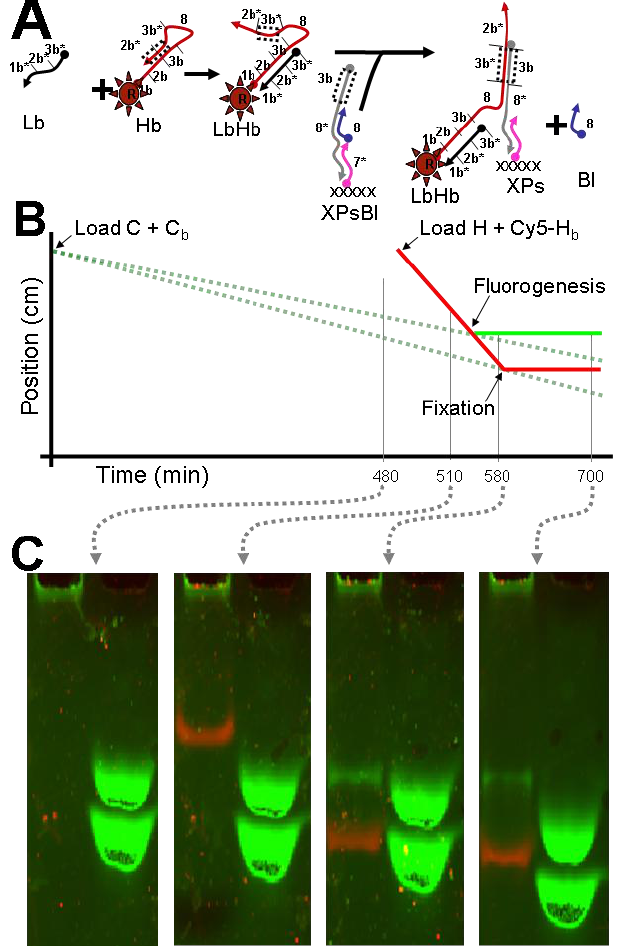
Figure 4. DNA reactions cause fluorescence and mobility changes in situ . ( A ) Schematic illustration of the fixation reaction that leads to a decrease in the mobility of Cy5-labeled Hb; ( B ) Graph showing the motion of the DNA species over time in the gel. The L species are injected and electrophorese down the gel. H species are then injected; they move much faster. The lines intersect and reactions occur at specific locations; ( C ) Two-color fluorescence images of the experimental results showing the location of the fluorescein- labeled L (green) and Cy5-labeled Hb (red) species as they migrate. As above, fluorescein- labeled L in the right lane indicate the locations of the invisible L species. As H overtakes L, the fluorogenic reaction (above) de-quenches embedded fluorescein and creates a new green line. Hb, labeled with Cy5 (red) can be seen to arrest its motion after frame 3.